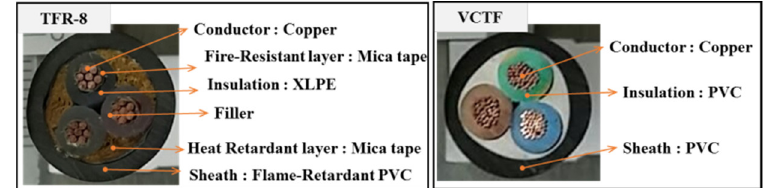
Figure 3. Configuration of the cable sample. Table 1. Specification of the test samples.